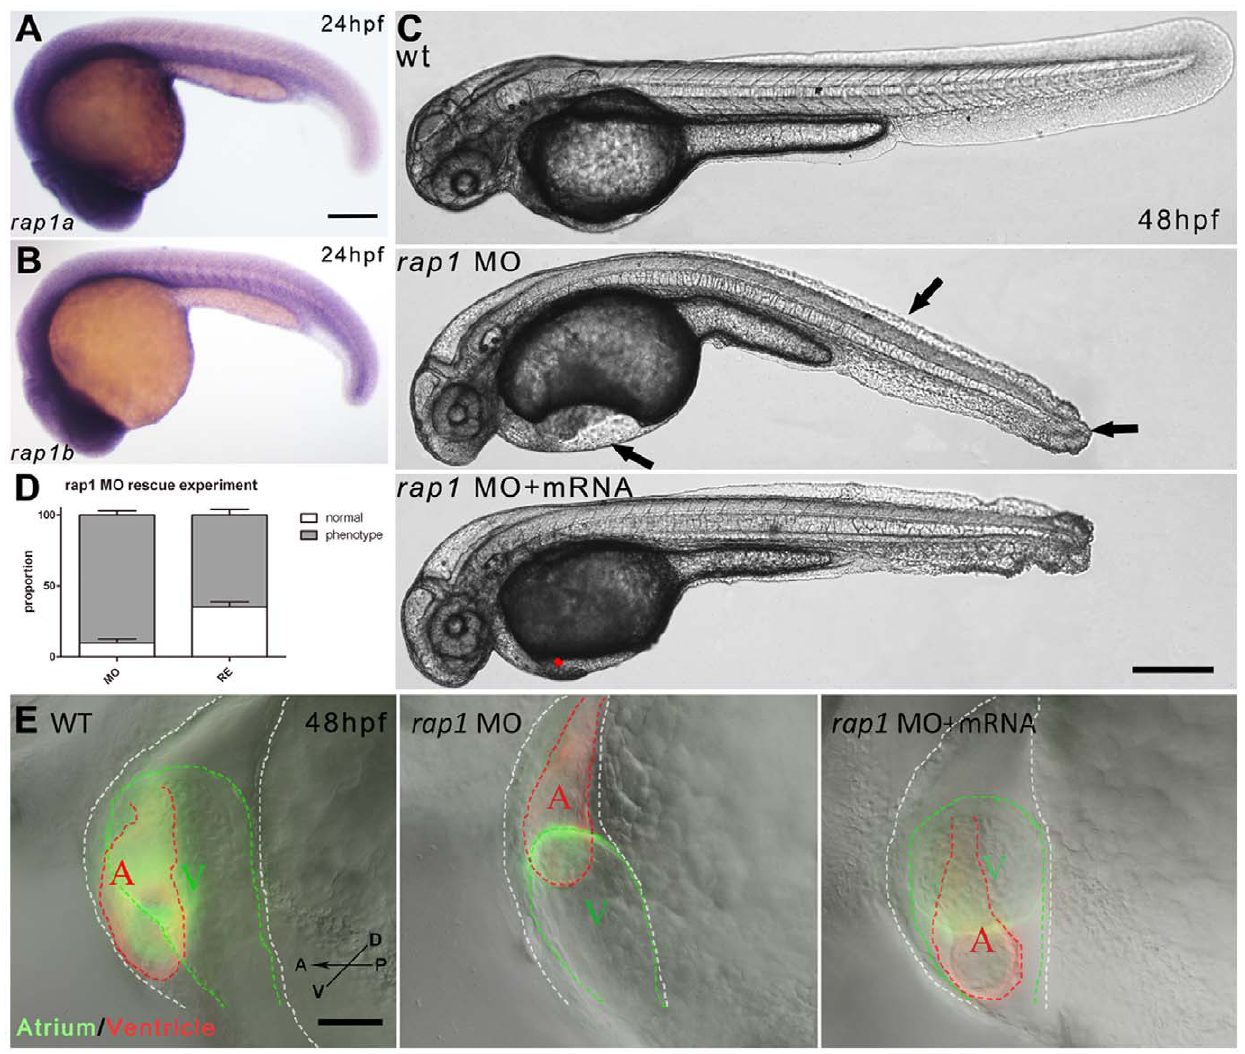
Figure 1. Rap1 knock-down led to abnormal heart and caudal fin development in zebrafish. Ubiquitous expressions of (A) rap1a and (B) rap1b were shown at 24 hpf. rap1 MO injection led to the heart and caudal fin-fold phenotypes and curved trunk (arrows in C) at 48 hpf compared to wild type fish, and rap1 mRNA partially rescued the heart malformation in rap1 animals (C). The statistics indicates the proportion of fish embryos with heart phenotype was significantly decreased by rap1 mRNA rescue (D). mp157e fish was used to show the heart morphology of wild type, morphant and rescued morphant at 48 hpf at a higher magnification, the atrium (red), ventricle (green) and cardiocoelom (white) are marked by color dotted lines (E). In rap1 MO larvae, the heart apparently failed to develop properly, while rap1 mRNAs partially restored the heart looping failure.